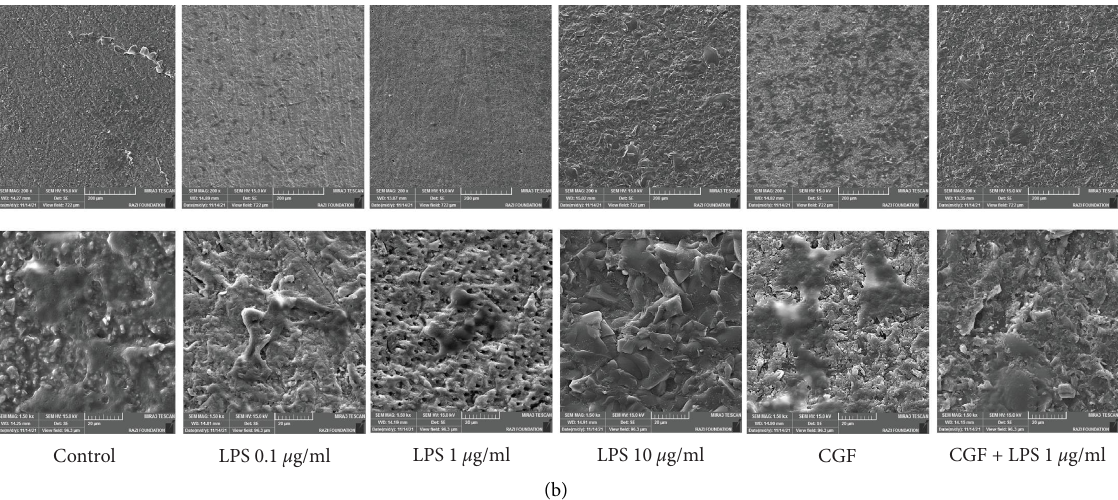
Figure 2: (a) Scanning electron microscopy (SEM) of dental pulp stem cells (DPSCs) cultured onto dentin discs (A1, 2) treated with LPS 0.1 µ g/ml (B), LPS 1 µ g/ml (C), LPS 10 µ g/ml (D), CGF (E), LPS plus CGF (F), and the control group lacking LPS/CGF (G). Te dentin surface and dentinal tubules can be seen in part (A) Adhesion of DPSCs ( ∗ ) is evident with clear cytoplasmic extensions ( ∗∗ ) in all groups except for the LPS 10 µ g/ml group. (b) Scanning electron microscopy (SEM) of dental pulp stem cells (DPSCs) cultured onto treated dentin discs. Under 200x magnifcation (upper row), it is evident that the highest cell number was in the concentrated growth factor (CGF) group, followed by the lipopolysaccharide (LPS) 0.1 µ g/ml and control groups. Tere are nearly no viable cells in the LPS 10 µ g/ml group. Tere was probably higher cell proliferation and attachment in the CGF+LPS 1 µ g/ml group compared with LPS 1 µ